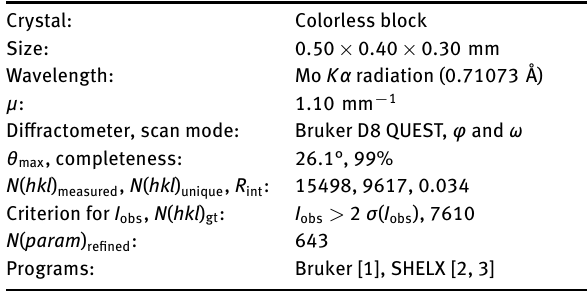
Table 2: Fractional atomic coordinates and isotropic or equivalent isotropic displacement parameters (Å 2